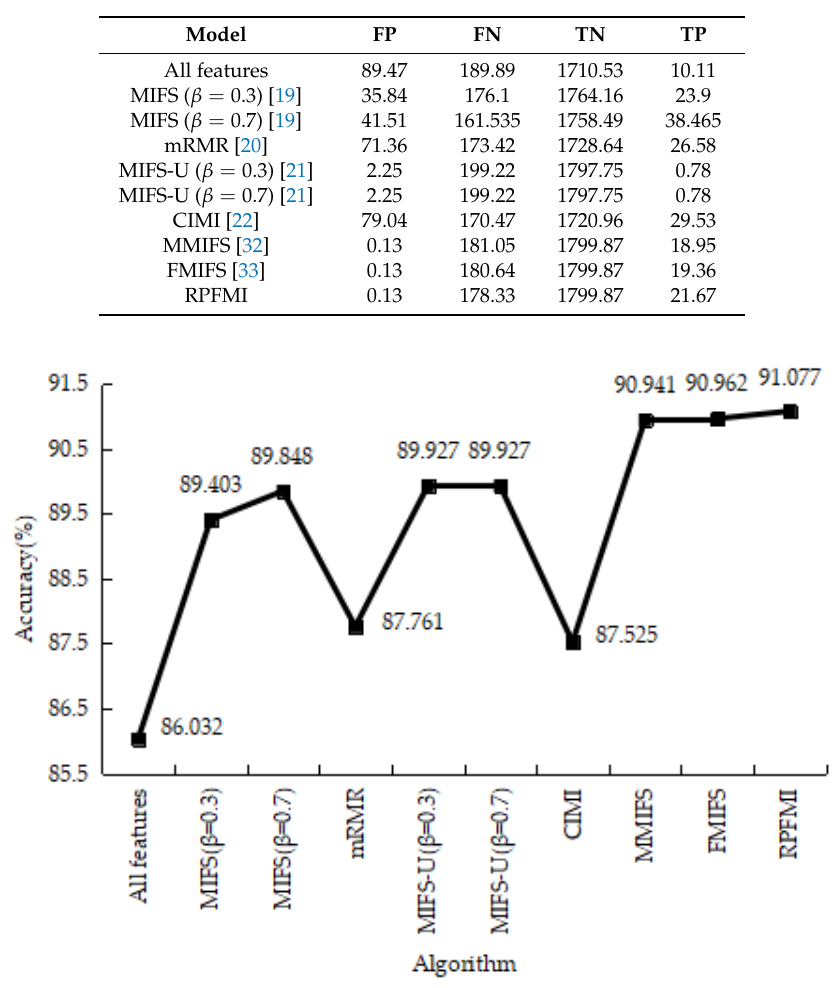
Table 10. Confusion matrices in different models using the remote to login (R2L) test data.